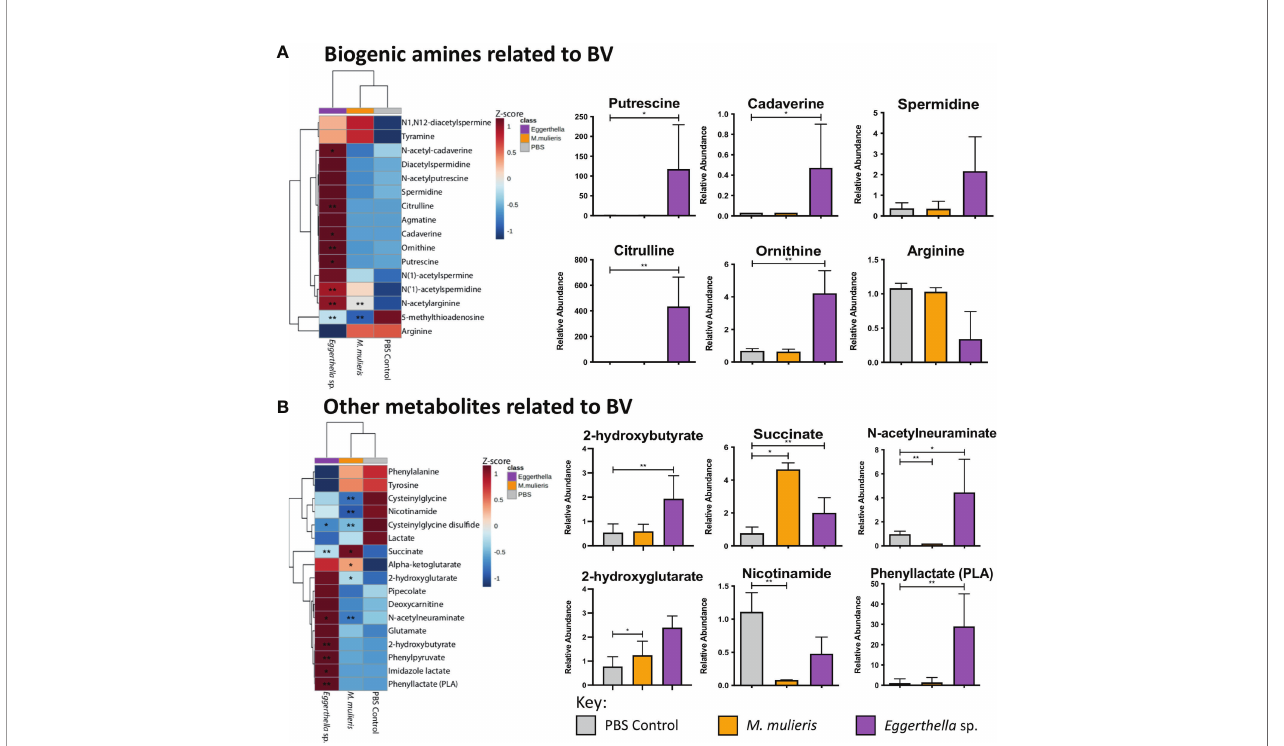
FIGURE 6 | Eggerthella sp. signi fi cantly elevated the production of metabolites associated with biogenic amines and M. mulieris signi fi cantly altered metabolites related to energy metabolism. Hierarchical clustering analysis (HCA) and relative abundance of the BV-associated metabolites of Eggerthella sp. MVA1 and M. mulieris UPII-28I infection compared to the PBS mock-infected control: biogenic amines (A) and other metabolites related to BV symptoms (B) . HCA was performed using Euclidean distance measures and average linkage clustering algorithms. Statistical signi fi cance was calculated using Student ’ s t-tests with Welch ’ s correction compared to PBS mock-infected control; *, p <0.05; **, p